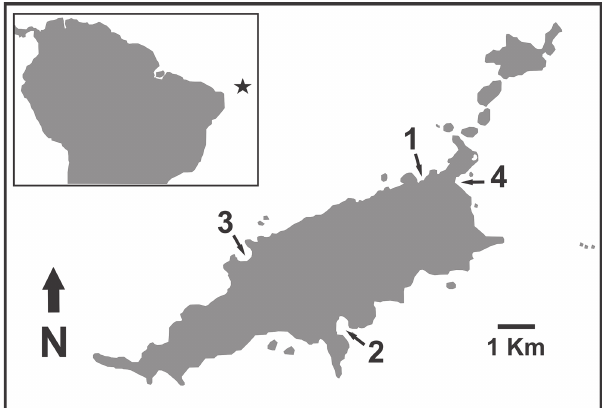
Fig. 1. Fernando de Noronha Archipelago (depicted by the star), 345 km off the Brazilian coast: 1 and 2 indicate sites where juveniles Negaprion brevirostris were observed between 2008 and 2009; 3 and 4 indicates sites where subadult and adult individuals were sighted chasing schools of sardines in 2006, 2012 and